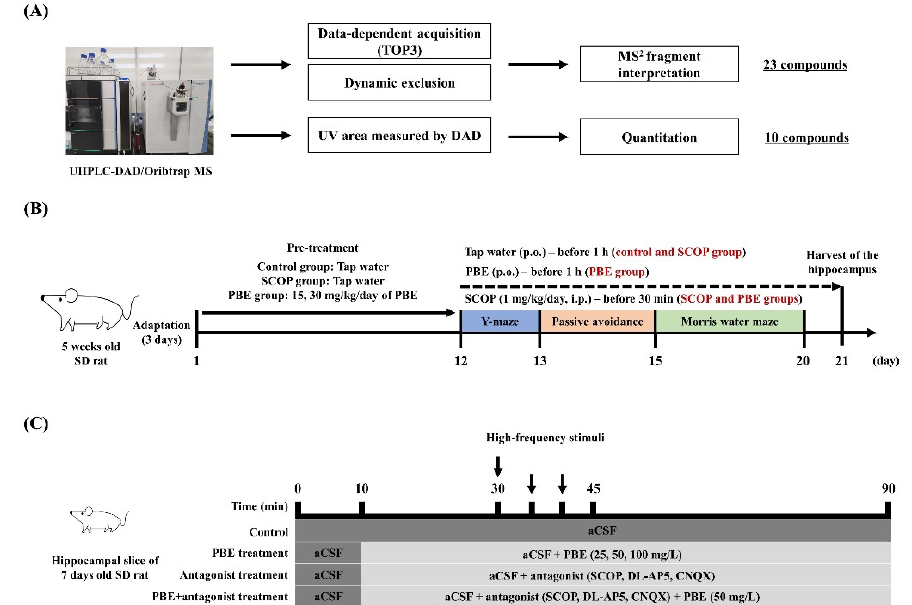
Figure 1. Experimental design in this study. ( A ) Phenolic analysis using UHPLC-DAD/Orbitrap MS/MS analysis, ( B ) Animal behavioral study in Sprague-Dawley (SD) rat and ( C ) measurement of long-term potentiation in hippocampal tissue of young SD rat. aCSF, artificial cerebrospinal fluid; CNQX, 6-cyano-7-nitroquinoxaline-2,3-dione; DAD, diode array detector; DL-AP5, DL-2-amino-5- phosphonopentanoic acid; MS, mass spectrometer; PBE, Pinus densiflora Sieb. et Zucc. bark extract; SCOP, Scopolamine; UV,